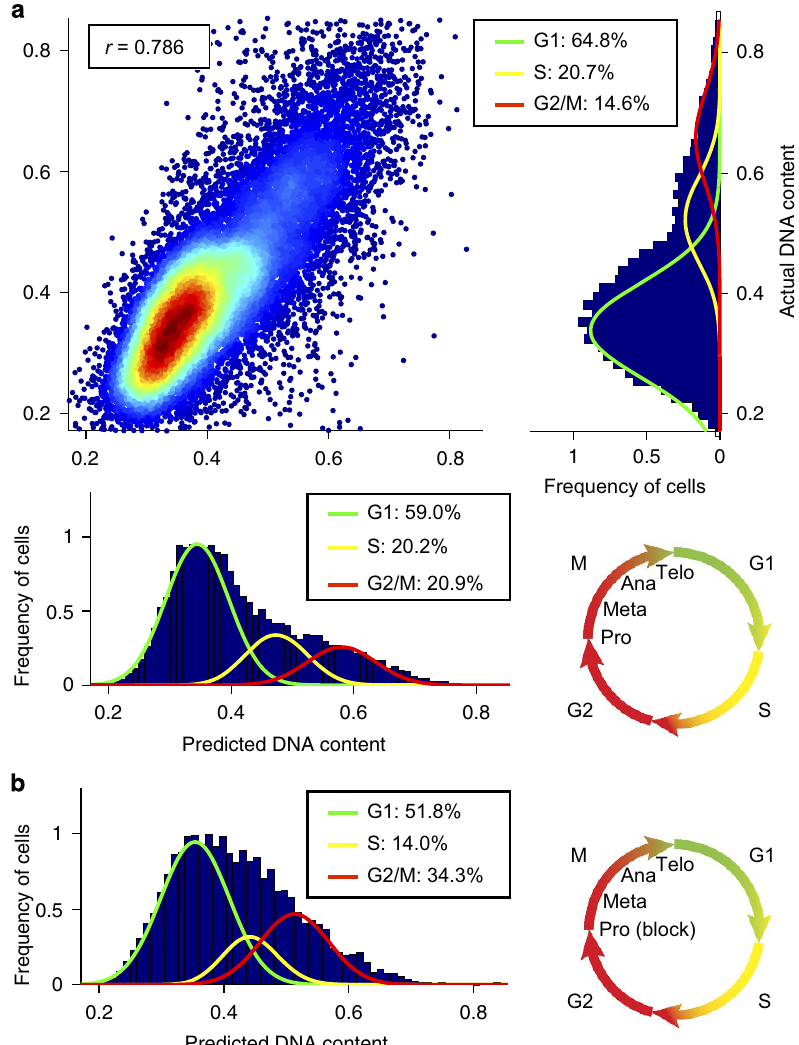
Figure 4 | Label-free prediction of DNA content for live Jurkat cells and detection of a phase blockage. ( a ) Supervised machine learning (trained using live cells stained with DRAQ5 to determine the DNA content) allows for robust label-free prediction of the DNA content of live cells based only on brightfield and darkfield images. We find a Pearson correlation of r ¼ 0.786 ± 0.010 (error bars indicate the s.d. obtained via 10-fold cross-validation) between actual DNA content and predicted DNA content using regression (see Methods section). We believe this reduction in correlation from the value of 0.896 obtained for fixed cells to be a consequence of the greater variability of the uptake of the live DNA dye compared with the staining achieved with fixed cells. Despite the reduction in correlation a value of 0.786 is still high enough to make this a viable method for the cell cycle analysis of live cells. As previously, we determine the fraction of cells in the G1, S and G2/M phases using the Watson pragmatic curve fitting algorithm. ( b ) We predict an increase of 13.4% in the G2/M phase after the cells were treated with 50 m M Nocodazole, which is in good agreement with the average increase of 19.0 ± 11.0% in G2/M as was found for three independent cell populations under the same treatment (Supplementary Figure 3). The phase-blocked data set was not labelled with any marker. Instead, we trained our machine learning algorithm on the untreated data set, which was labelled with a DRAQ5 DNA stain (see a ) and used the trained machine learning algorithm to predict the DNA stain of the blocked